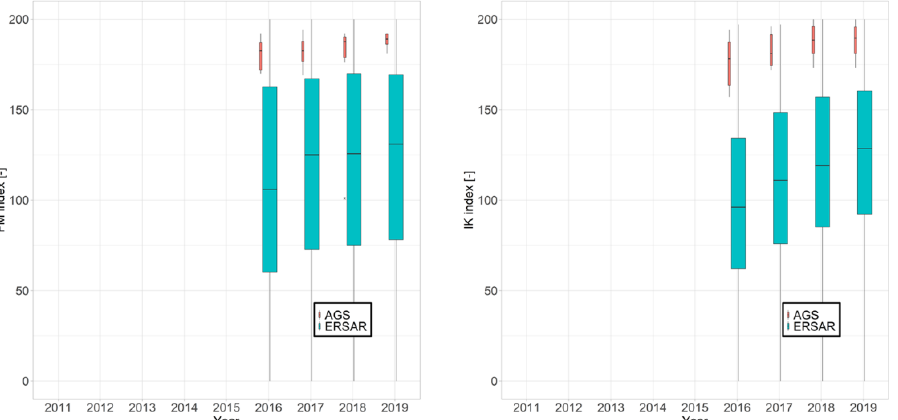
Figure 2. Box-whisker plots depicting the distribution of data points in the period of 2016 to 2019 (the indices were not implemented until 2016). The width of the boxes is proportional to the total number of data points. Outliers are depicted as crosses (x). ( Left ) Flow-measuring (FM) index. ( Right ) Infrastructure knowledge (IK) index.